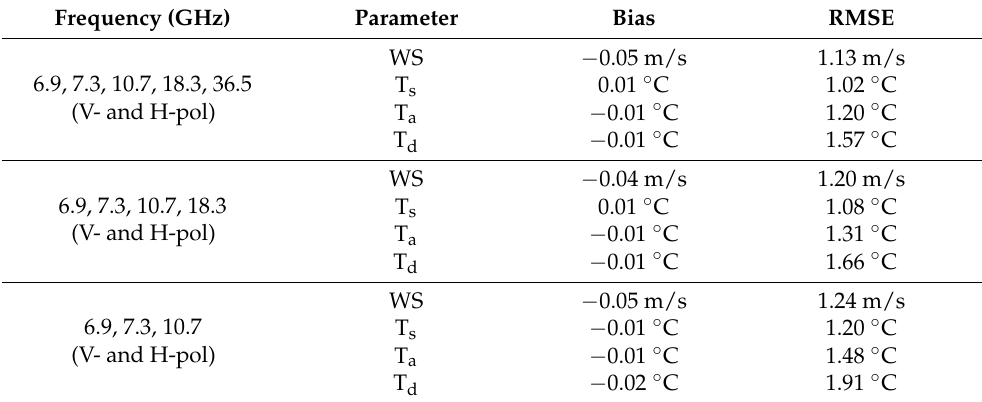
Table 4. The bias and root-mean-square error (RMSE) of multi-parameter BPNN model-retrieved sea surface wind speed (WS), sea surface temperature (T s ), near-surface air temperature (T a ), and dewpoint temperature (T d ), using brightness temperatures from different channel